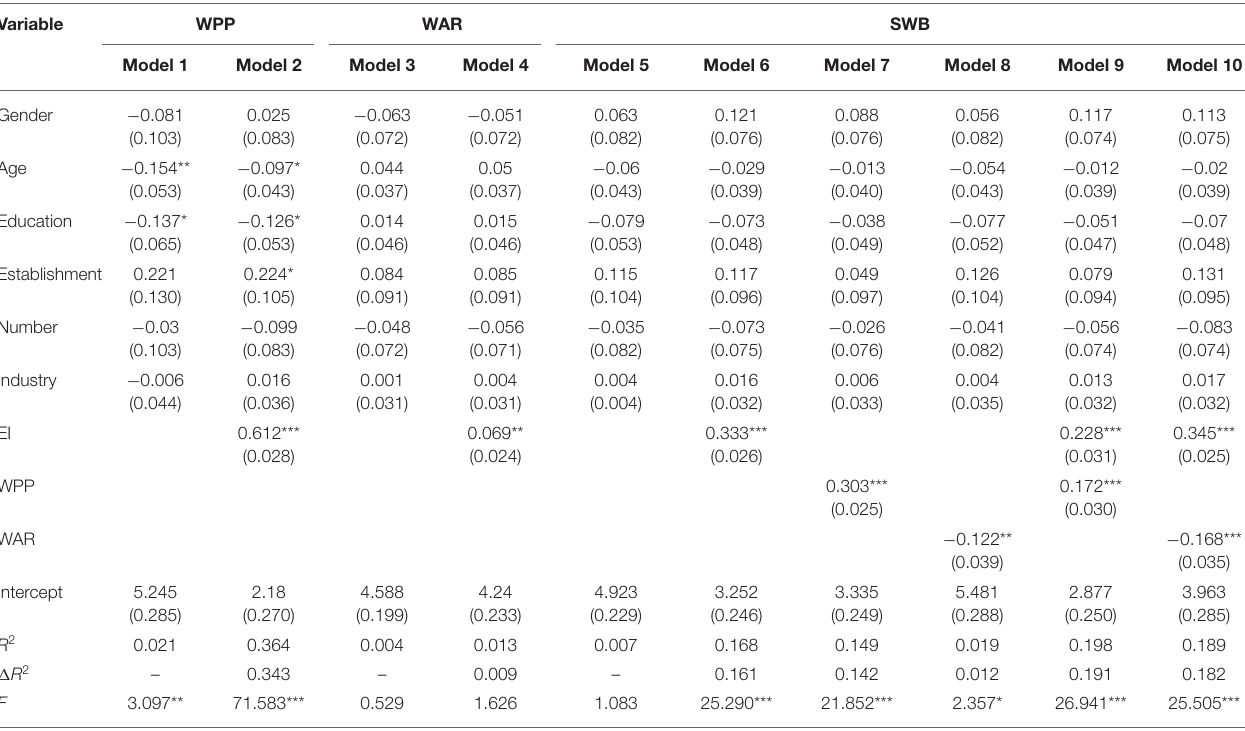
TABLE 4 | The mediation effect test of work rumination.